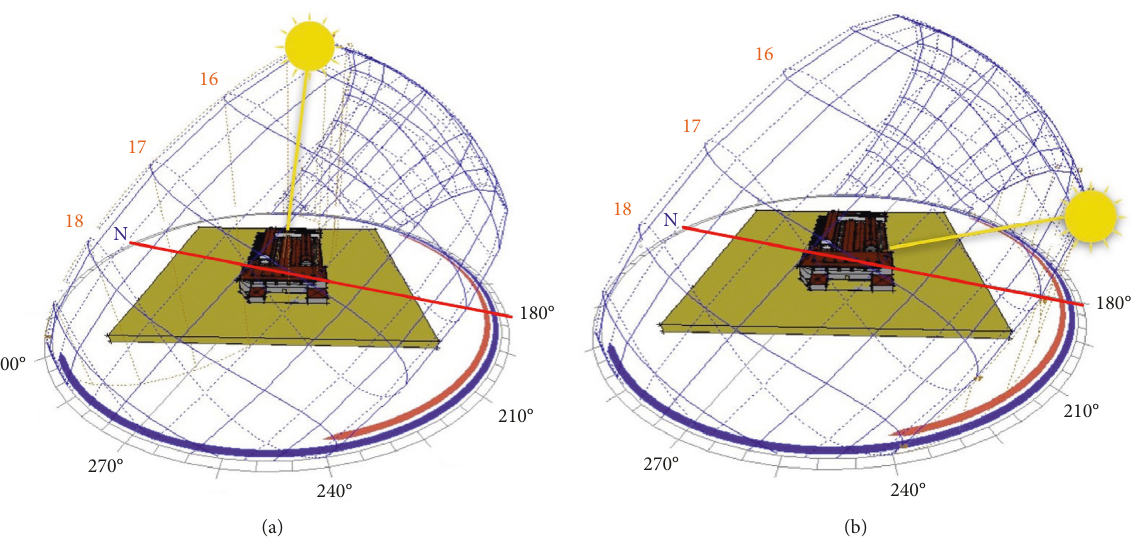
Figure 8: Solar simulation graphs. (a) Summer solstice, Atarazanas , Seville, Spain. (b) Winter solstice, Atarazanas , Seville,